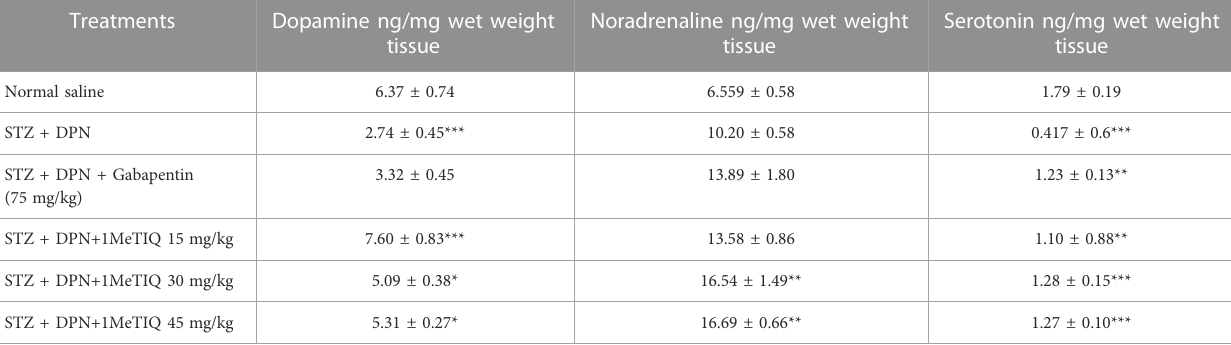
TABLE2Concentrationsofneurotransmittersinstriataltissueafterthestreptozotocinprotocol(i.e.,STZ+DPN)aloneorincombinationwitheithergabapentinor 1MeTIQ. Note: * p < 0.05, ** p < 0.01, *** p <